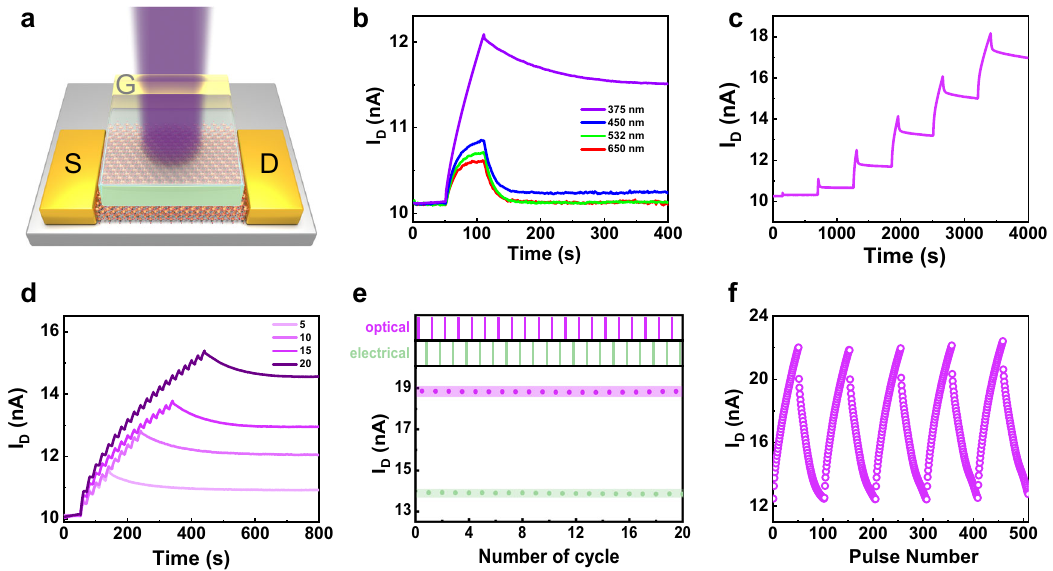
Fig. 1 Optical sensing and non-volatile multi-level storage characteristics. a Schematic illustration of the neuromorphic transistor stimulated using 375 nm UV light. The VO 2 fi lm serves as a channel between the source (S) and drain (D) electrodes, and ionic liquid is used as a gating medium. b I D as a function of time under different light wavelengths (64 mW/cm 2 for 60 s). c I D response to UV irradiation at different durations (84 mW/cm 2 for 1 s, 10 s, 50 s, 100 s, 150 s, 200 s). d Spike-number-dependent plasticity under UV irradiation (84 mW/cm 2 for 10 s). e Pulse-switching characteristics. The optical potentiation (84 mW/cm 2 for 20 s) and electrical depression ( − 2.5 V for 20 s) were used for the switching process. I D was read 2 s after the light and voltage pulse stimuli. f Light-controlled LTP (light intensity 84 mW/cm 2 for 10 s, spaced 10 s apart) and V G -controlled LTD ( − 1.5 V to − 3.5 V, duration